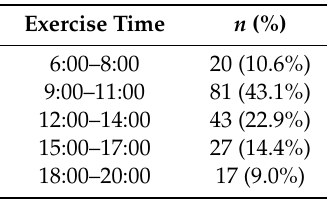
Table 3. Exercise time of the participants in the green spaces.